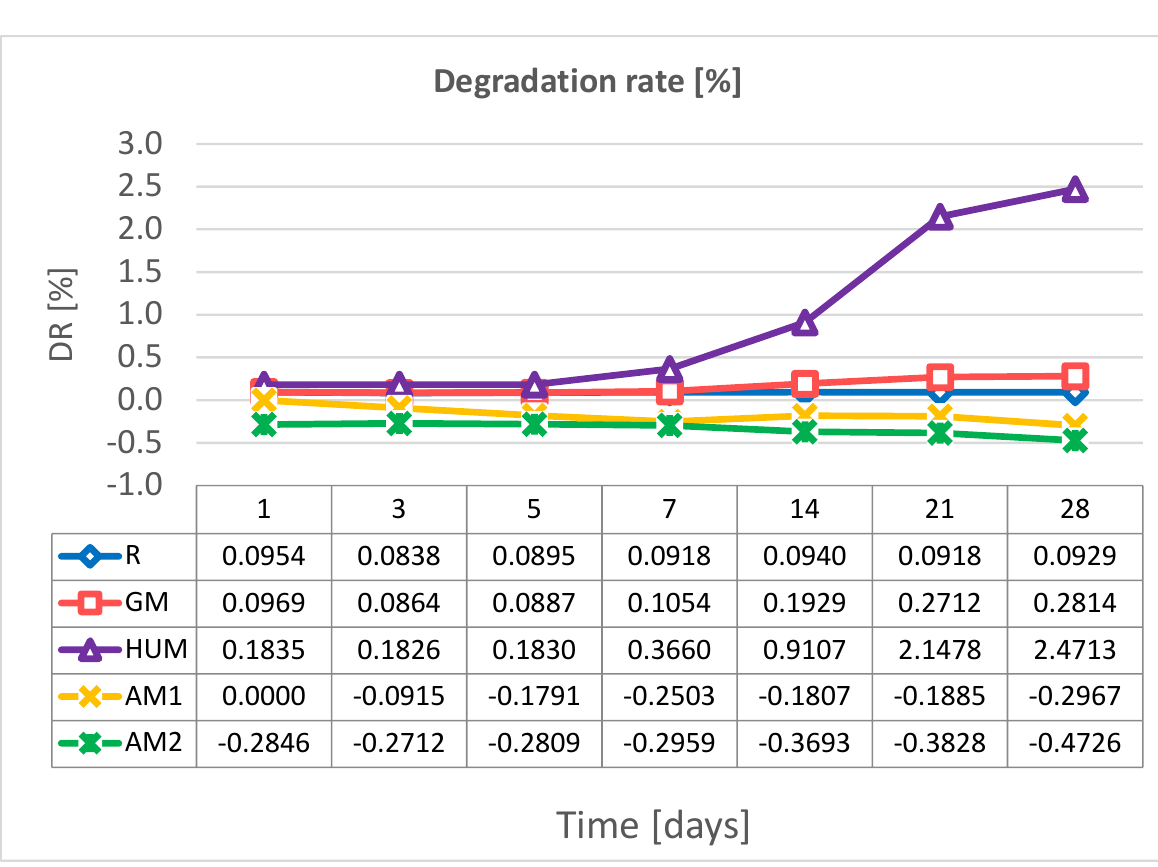
Figure 6. Variation of degradation rate over a period of 28 days in SBF, at 37 °C, for experimental PMMA bone cements.